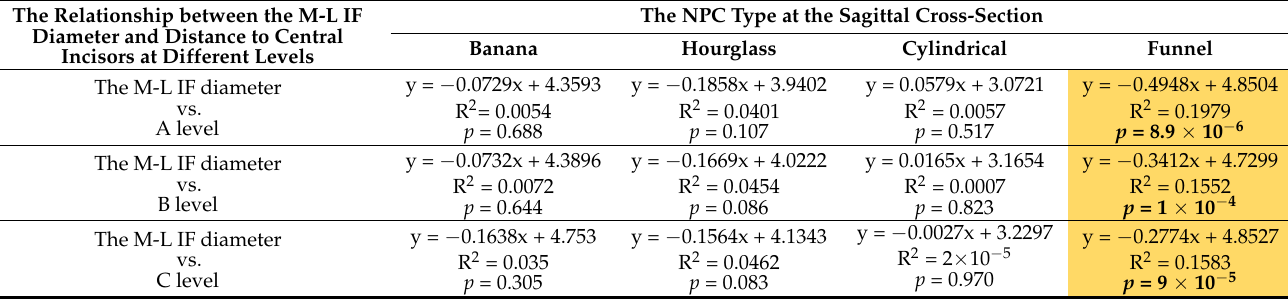
Table 3. Relationship between M-L IF diameter and distance to central incisors at different levels according to NPC type. The Relationship between the M-L IF Diameter and Distance to Central Incisors at Different